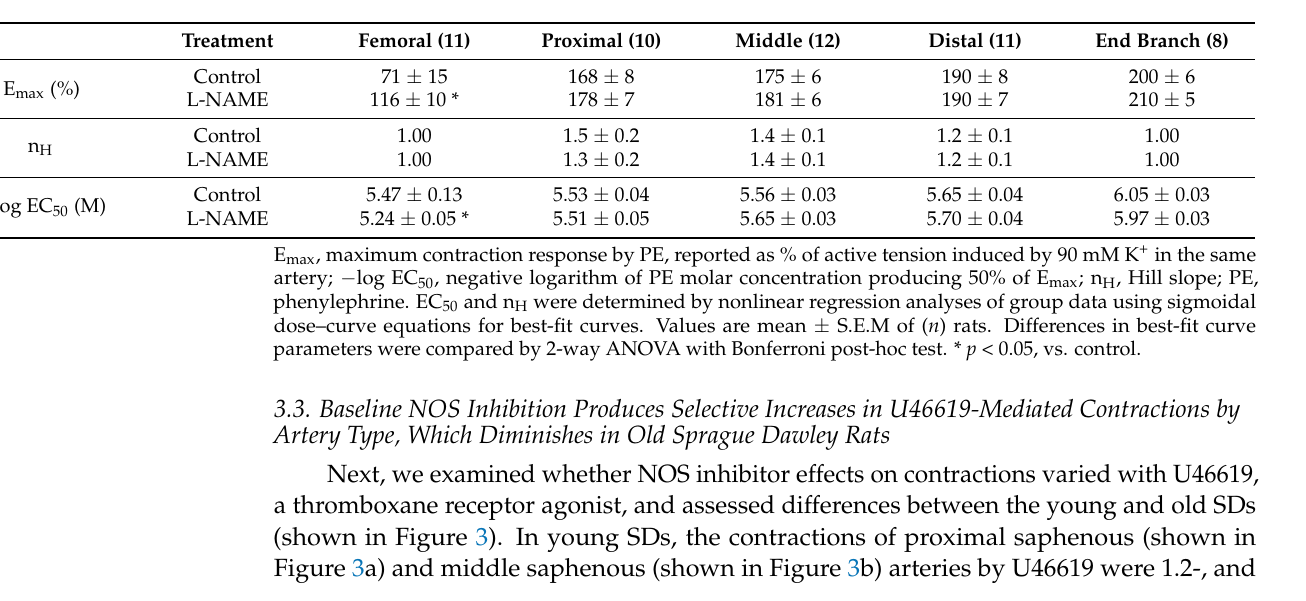
Figure 2. The effects of NO synthase inhibitor L-NAME on phenylephrine-induced contractions of ( a ) femoral, ( b ) proximal, ( c ) middle, ( d ) distal saphenous artery segments, and ( e ) caudal branches from young Sprague Dawley rats. The results are expressed as mean ± S.E.M of ( n ) rats. Lines represent best-fit four parameter sigmoidal dose response curves. # p < 0.05, vs. E max control; ‡ p < 0.05, vs. − logEC 50 control by Student’s t -test. Table 2. The effect of pretreatment with L-NAME (100 µ M) on phenylephrine concentration–response curves in hind limb arteries from young Sprague Dawley